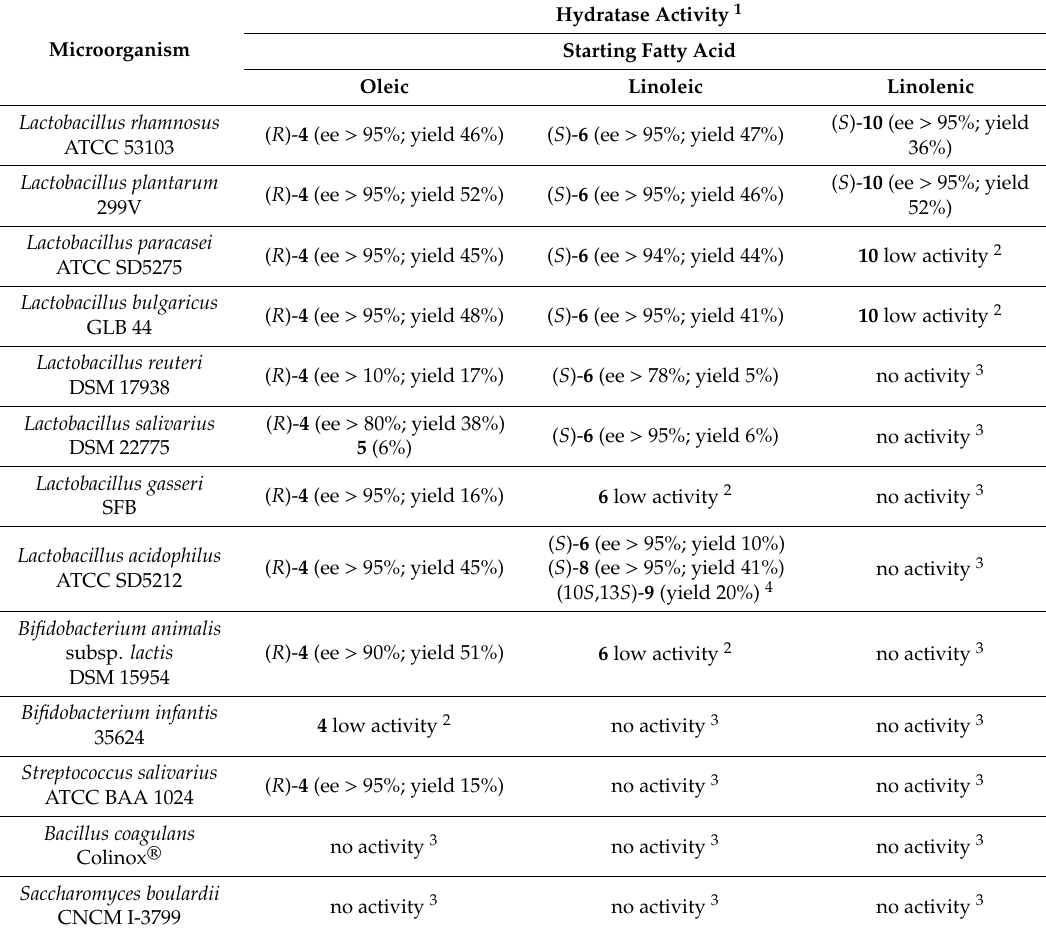
Table 1. Results of the microbial biotransformation of oleic, linoleic, and linolenic acid by probiotic